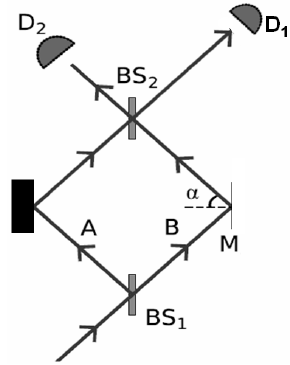
Figure 1. Mach–Zehnder interferometer and path of a light beam (or a particle, etc.). The mirror M on the right is a mesoscopic quantum object. Of particular interest are the photons (particles) emerging toward detector D 2 (adapted from Figure 2 of